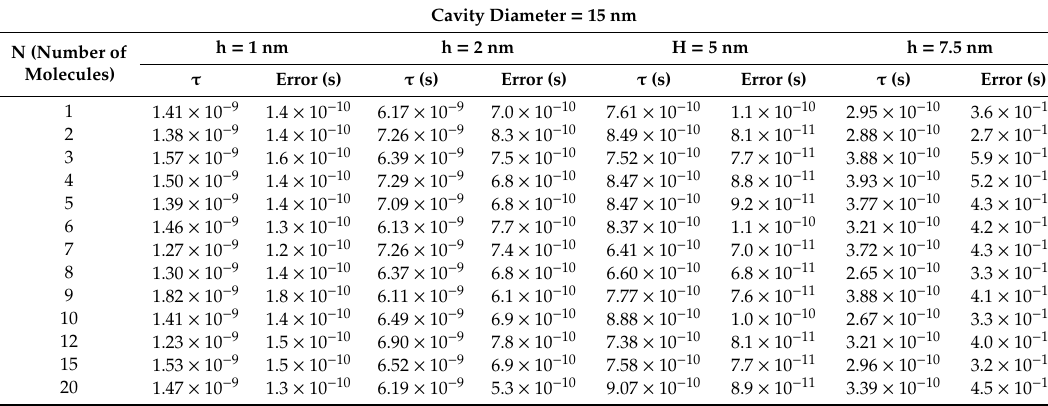
Table A5. Mean escape time ( τ ) and associated errors of di ff erent number molecules confined in a 15-nm spherical cavity for di ff erent entrance–escape hole diameters (h) calculated by the interactive random walk models for 10 2 runs.